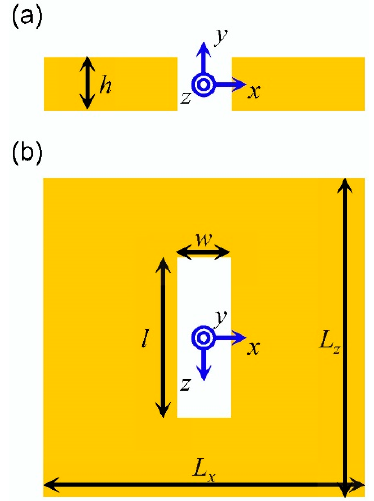
Figure 2. Schematic side view ( a ) and top view ( b ) of the configuration for the finite-difference time-domain (FDTD) simulation employed with transformation optics (TO) to generate non-uniform grids. The aperture width w , length l , and height h are fixed to 100, 300, and 100 nm, respectively. The film extends to the entire xz plane of the physical system, and its lengths are L x = L z = 8 μ m. The film is illuminated by a broadband incident electromagnetic (EM) wave from the top with the electric field polarized along the x axis.